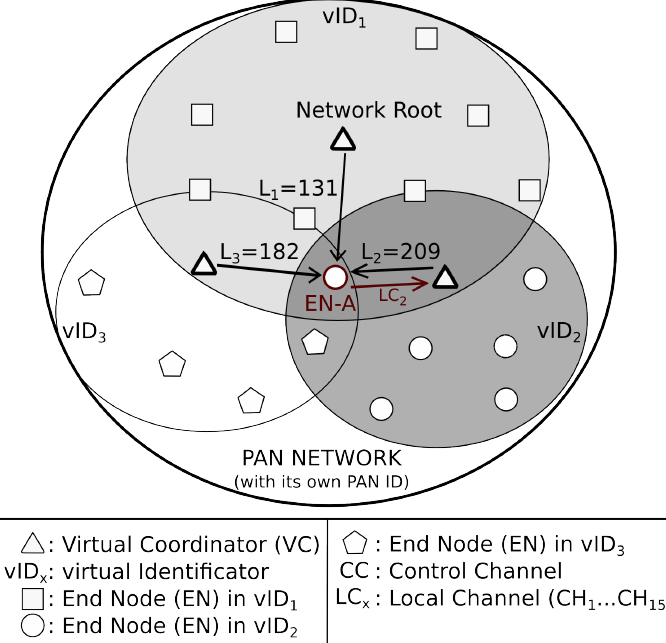
Figure 3. Example of link selection and role adoption